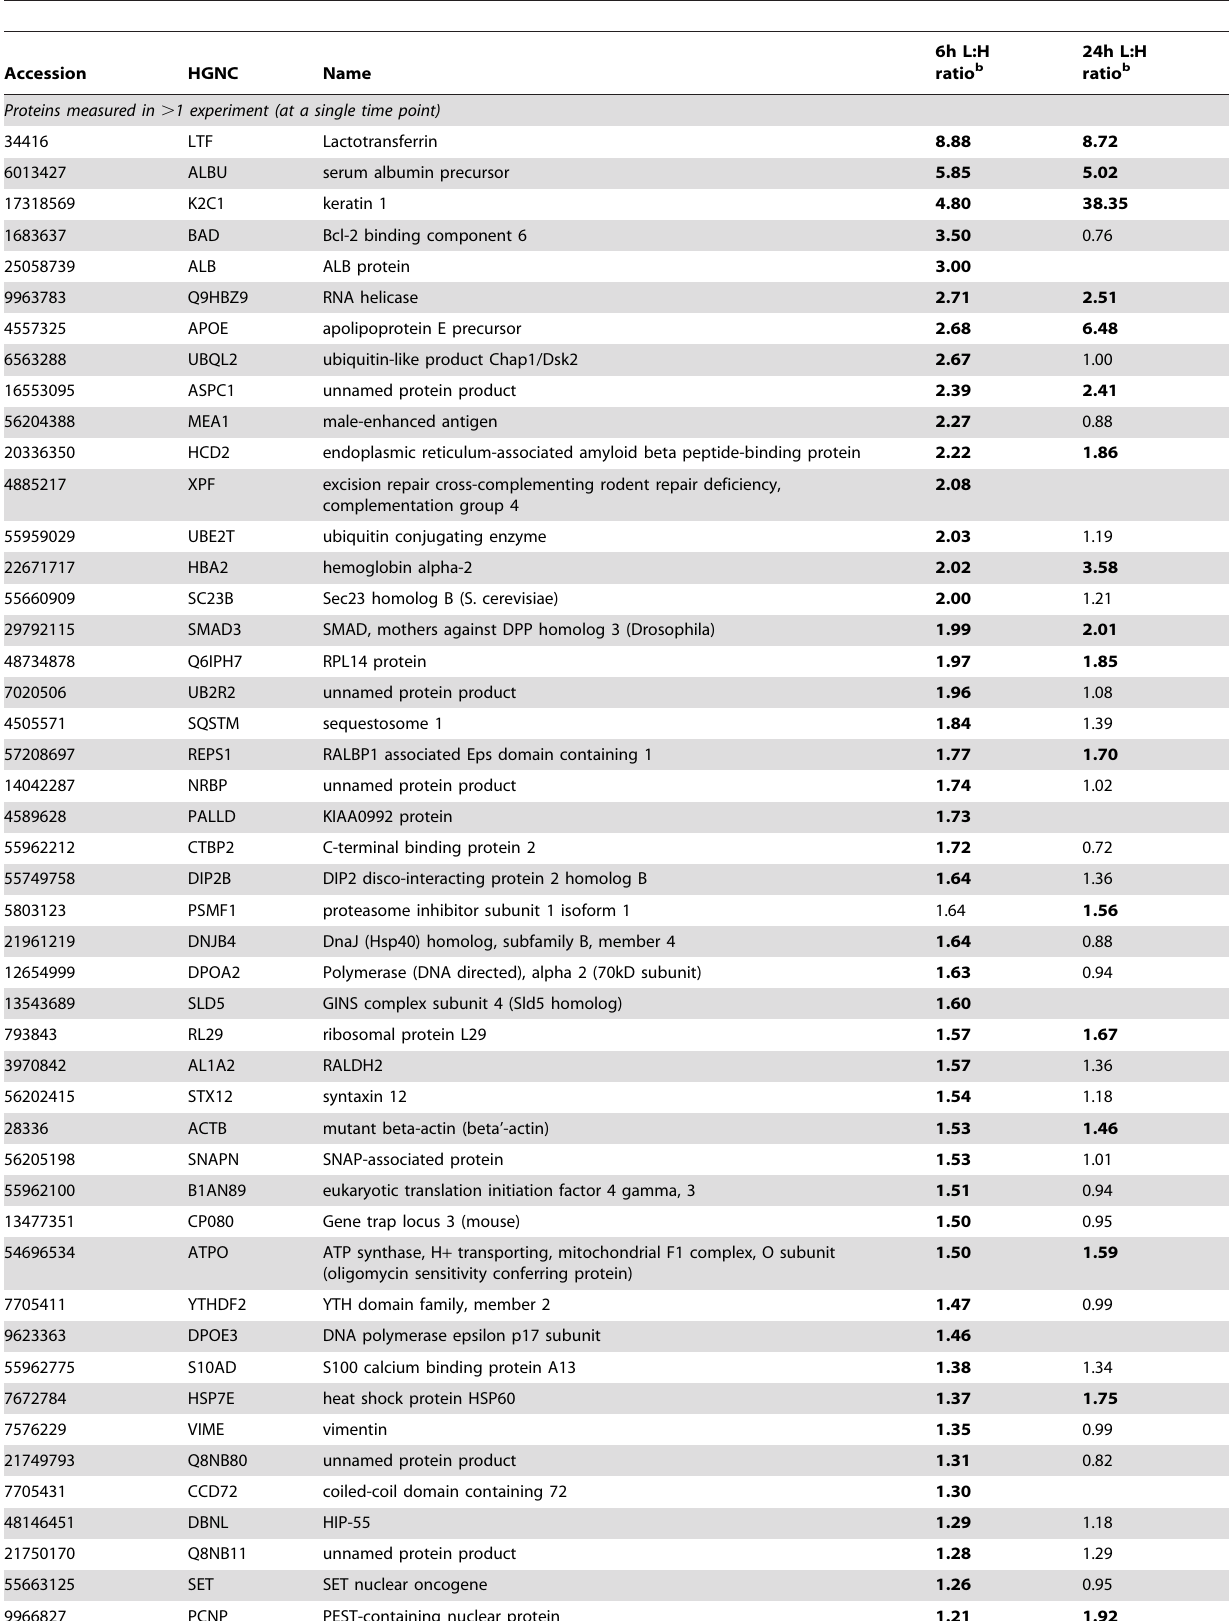
Table 1. HEK293 proteins increased . 95% confidence a